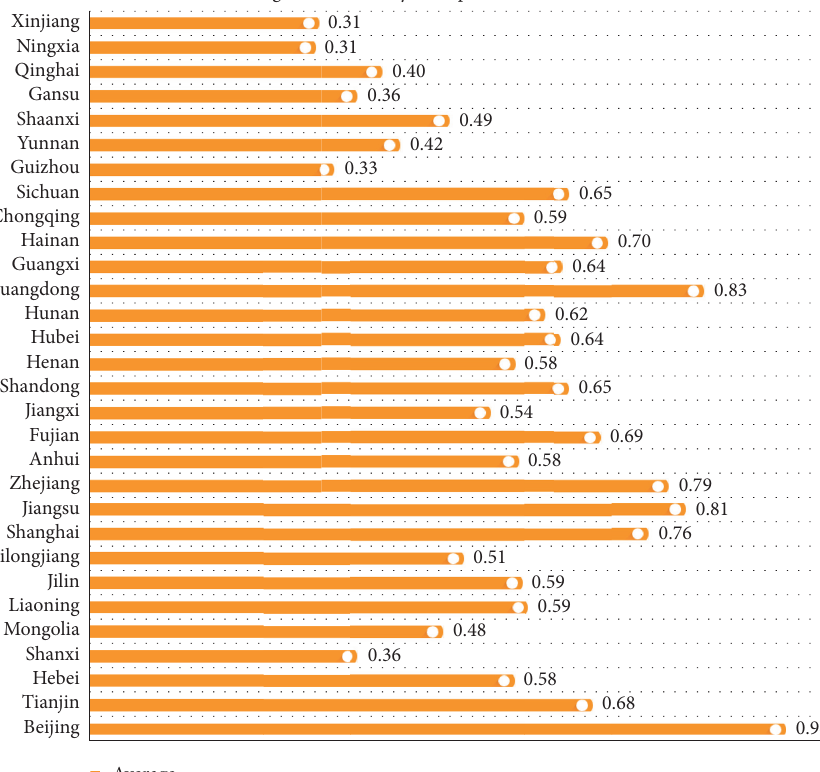
Figure 2: Average eco-efficiency of 30 provinces and cities in China (2008–2019).